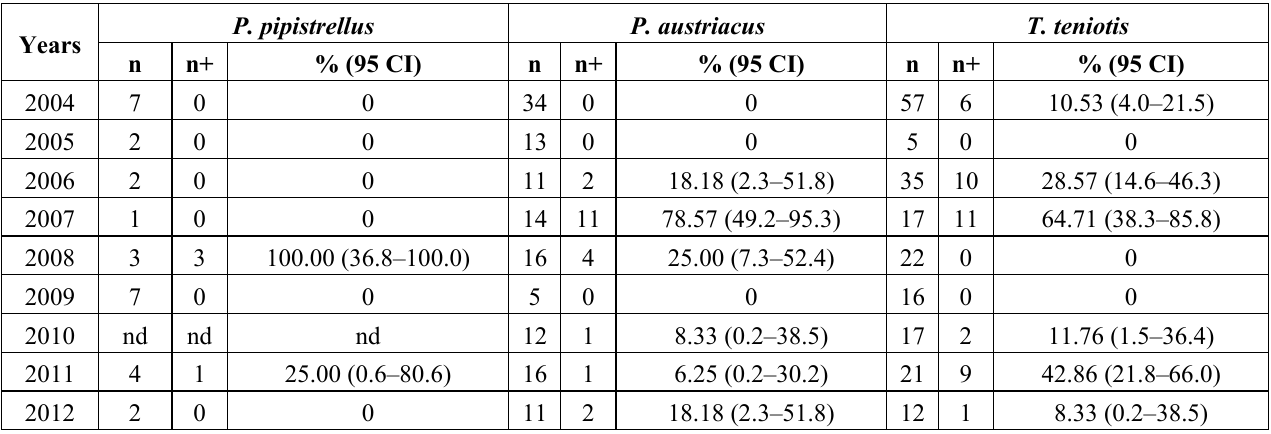
Table 5. The number of bat samples analyzed, by bat species and year.